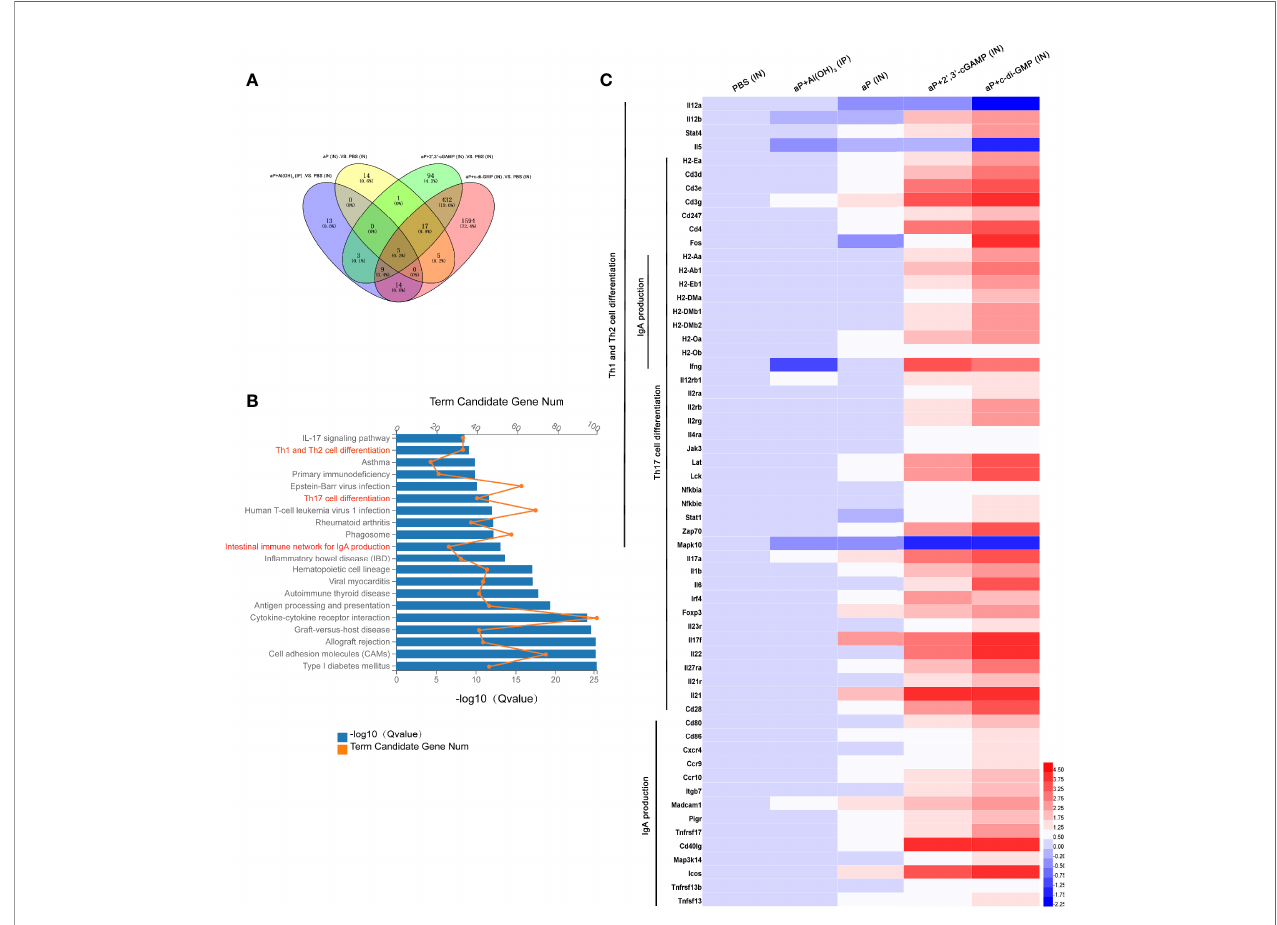
FIGURE 6 | Differentially expressed genes (DEGs) in the nasal mucosa from c-di-GMP-adjuvanted aP immunized mice. (A) The DEGs for different vaccine- immunized mice. PBS-immunized mice at 14 days after the last immunization were used for comparison, and the overlap is shown as a Venn diagram. (B) The top 20 and KEGG pathways of the DEGs detected in the nasal mucosa of aP+c-di-GMP/IN- and PBS/IN-immunized mice are shown. (C) RNA-seq heatmap for the nasal mucosa from mice immunized with PBS/IN, aP+Al(OH)3/IP, aP/IN, aP+2 ’ ,3 ’ -cGAMP/IN, or aP+c-di-GMP/IN (n = 5). The heatmap shows 59 signi fi cantly upregulated genes in aP+c-di-GMP/IN-immunized mice compared to those in other vaccine-immunized mice. Red (4.50) to blue (-2.25) were ranked by values of log2(value of gene